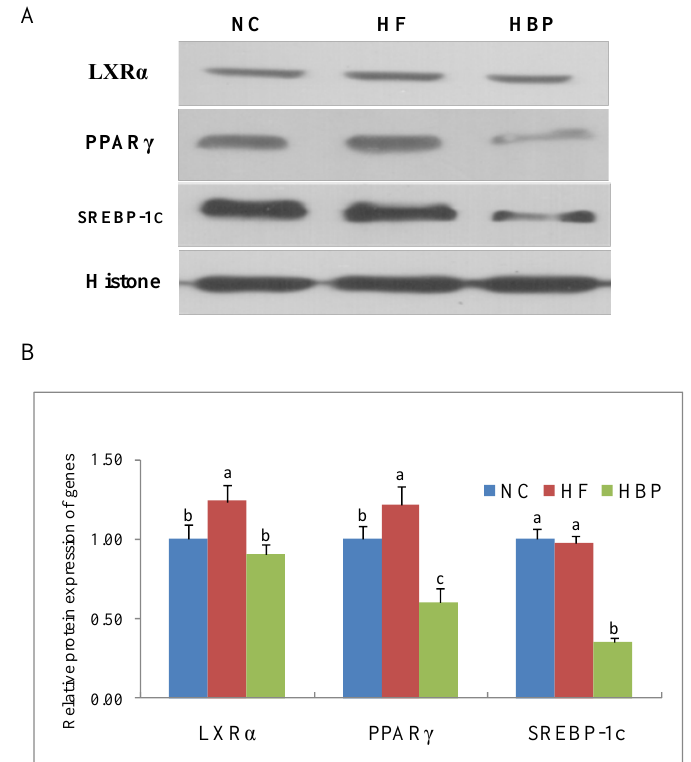
Figure 5. Effects of HBP on the nuclear translocation of transcriptional factors in the liver: ( A ) Repre- sentative bands of immunoblot blot; ( B ) relative protein levels of LXR α , PPAR γ , and SREBP-1c in nuclear protein. Values not sharing a letter in common are significantly different, p <